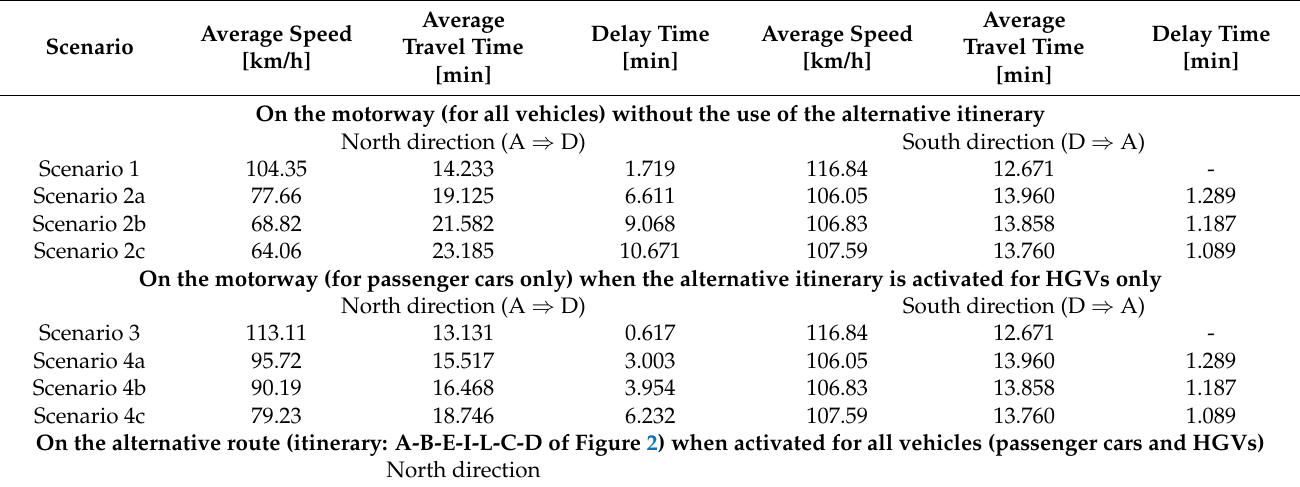
Table 4. Simulation results: average speed, average travel time, and delay time for the scenarios investigated when the north tube is partially or completely closed for 1 h (for example: Scenario 2c, delay time on the motorway for all vehicles = 23.185 − 12.514 = 10.671 min; Scenario 4c, delay time on the motorway for passenger cars only = 18.746 − 12.514 = 6.232 min; Scenario 5, delay time on the alternative itinerary for all vehicles = 26.800 − 12.514 = 14.286 min).